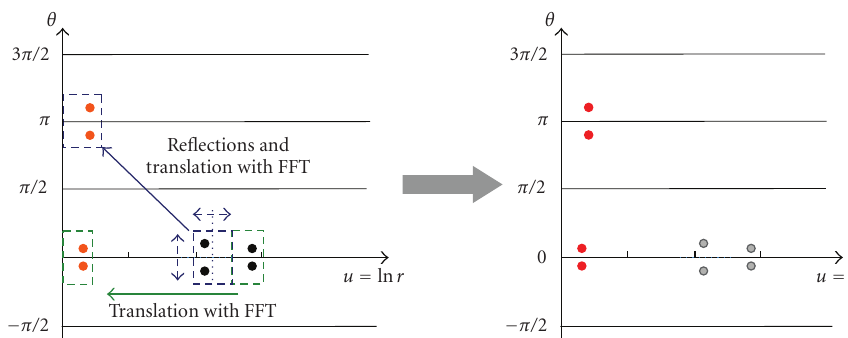
Figure 7: Modeling shifts of RFs of flashed probes. See text for detailed description.